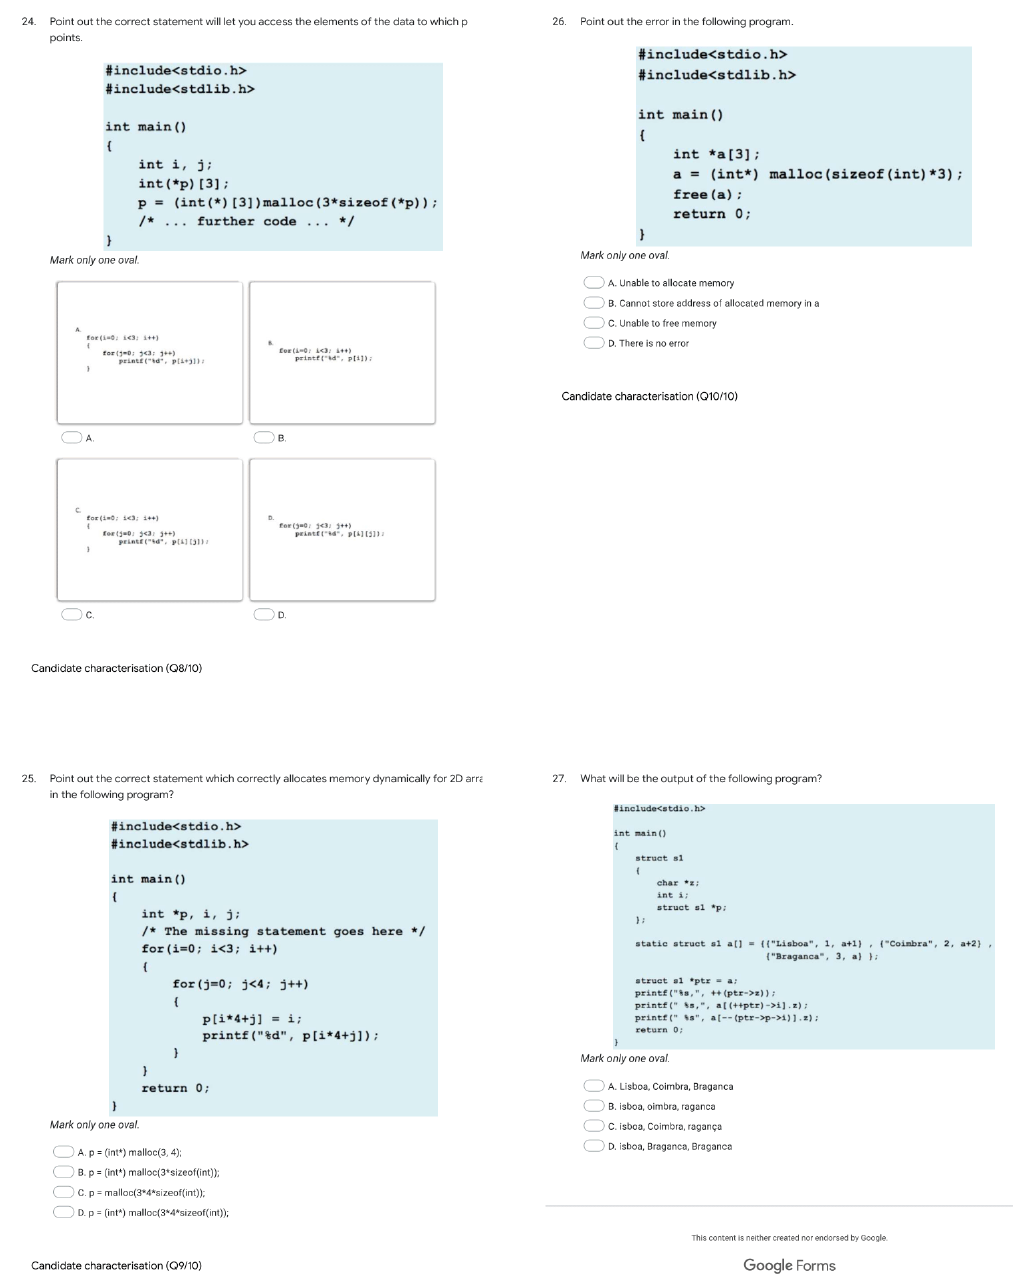
Figure A3. Technical questionnaire subpart (question 24 to 27).